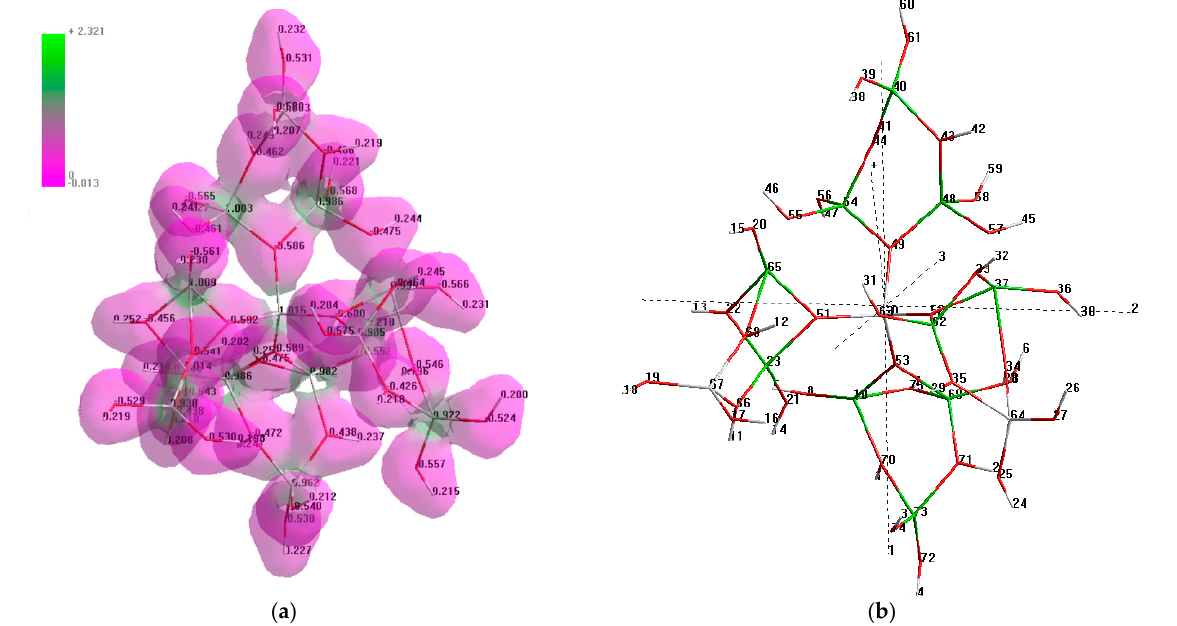
Figure 2. Molecular structure of the Al 132+ -complex: ( a ) Electrostatic potential (e/a 0 ), mapped onto an isosurface of total electron density of 0.018 e/a 03 ; ( b ) the marked aluminum atoms and their corresponding numbers, which were chosen for the simulations.